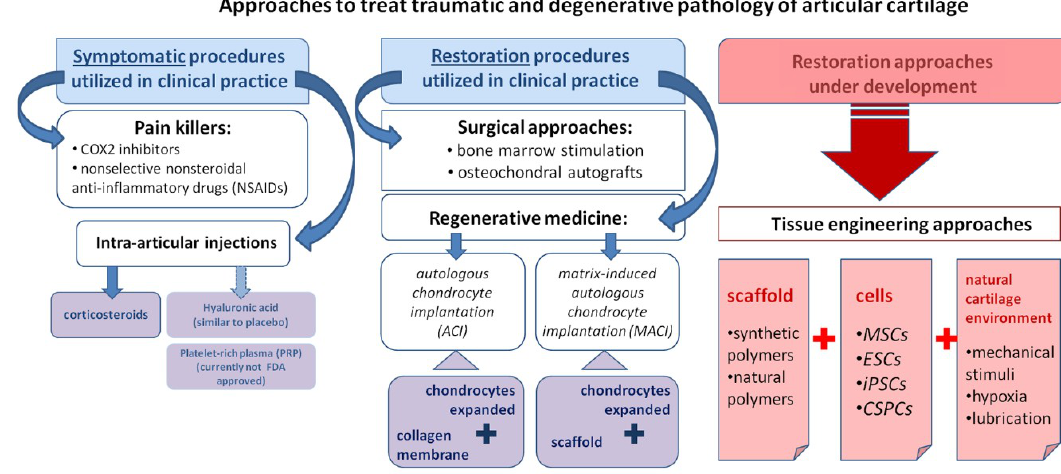
Figure 2. Illustration of approaches to the restoration of cartilage. Abbreviations: autologous chondrocyte implantation (ACI); matrix‑induced autologous chondrocyte implantation (MACI); mesenchymal stem cells (MSCs); embryonic stem cells (ESCs); induced pluripotent stem cells (iPSCs); chondrogenic stem/progenitor cells (CSPCs).